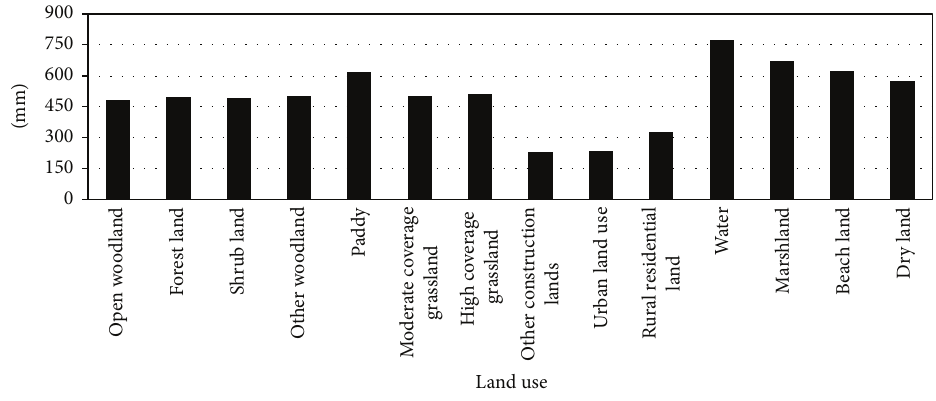
Figure 14: Average ET of lands used for various purposes in Tianjin from 1980 to